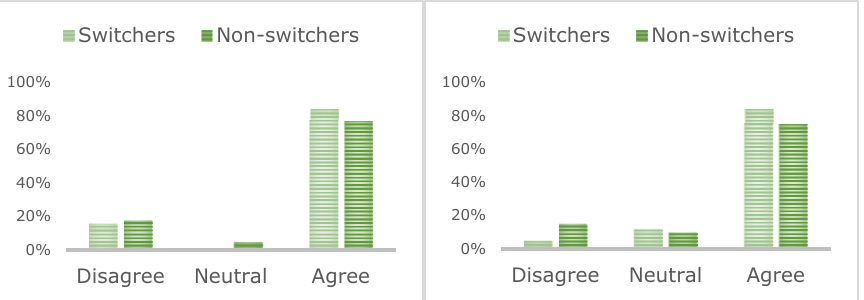
Figure 2. Patient consensus about enough information ( left ) and time ( right ) being given during the switching process.